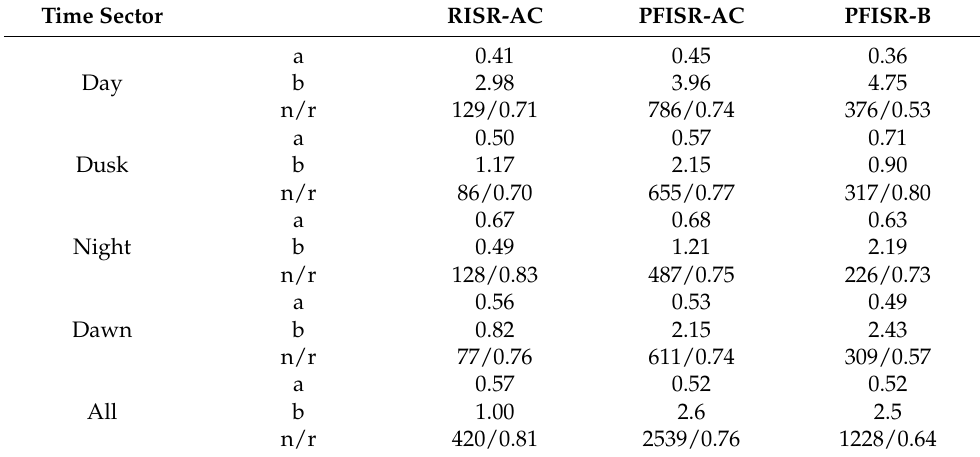
Table 2. Coefficients of a Linear Fit N eSwarm = a · N eISR + b, Total Number of Points and Correlation Coefficient to a Scatter Plot of Electron Density Measured by Swarm Versus Electron Density Measured by ISRs for all Conjunctions RISR-AC, PFISR-AC, and PFISR-B. Values of b are Given in Units of 10 10 m − 3 . Time Sector RISR-AC PFISR-AC